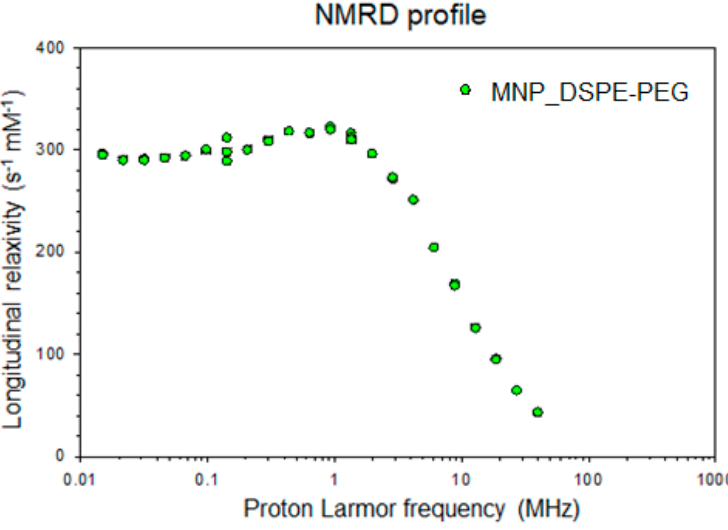
Figure 4. NMRD profile of MNP-DSPE-PEG acquired at 37 °C.